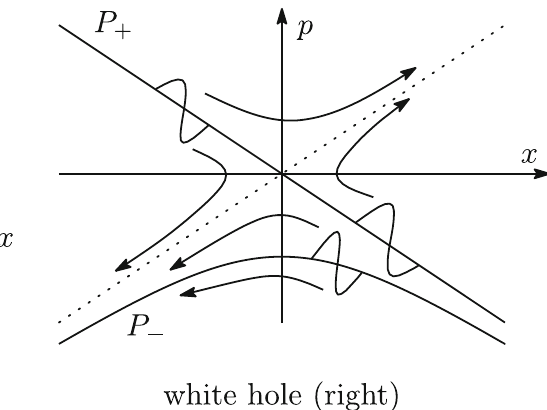
Fig. 4 The sketch of the propagation of finite fluctuations of P ± on the black hole (right) and the white hole (right) in the phase space. We can read off the propagation from the classical particle trajectories E = p 2 / 2 m − α x 2 / 2 in the phase space. (Recall that the droplet is the collection of the fermionic particles, and each point in the droplet moves according to (1.3).) In the black hole case, small fluctuations